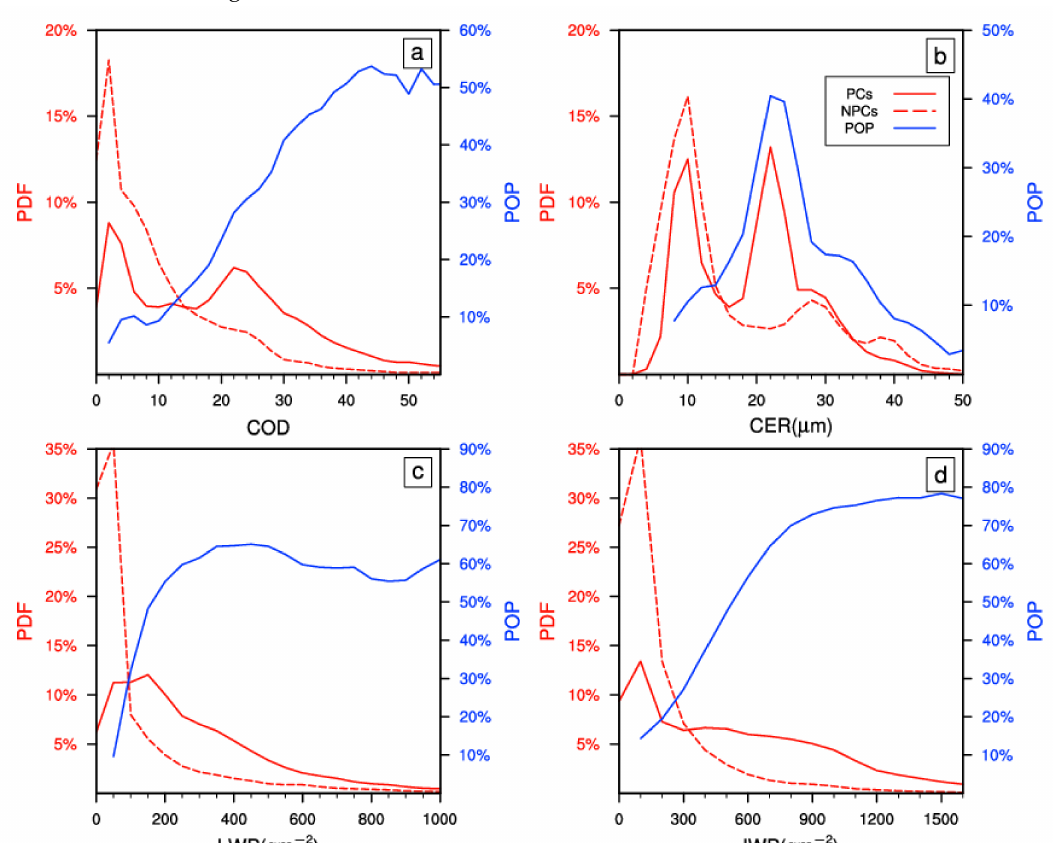
Figure 9. PDFs (red curves) of ( a ) COD, ( b ) CER, ( c ) LWP, and ( d ) IWP for precipitating and non- precipitating clouds. The blue curves are the corresponding parameter-dependent variations of the probability of precipitation. PDF = probability density function; POP = probability of precipitation; COD = cloud optical depth; CER = cloud effective radius; LWP = liquid water path; IWP = ice water